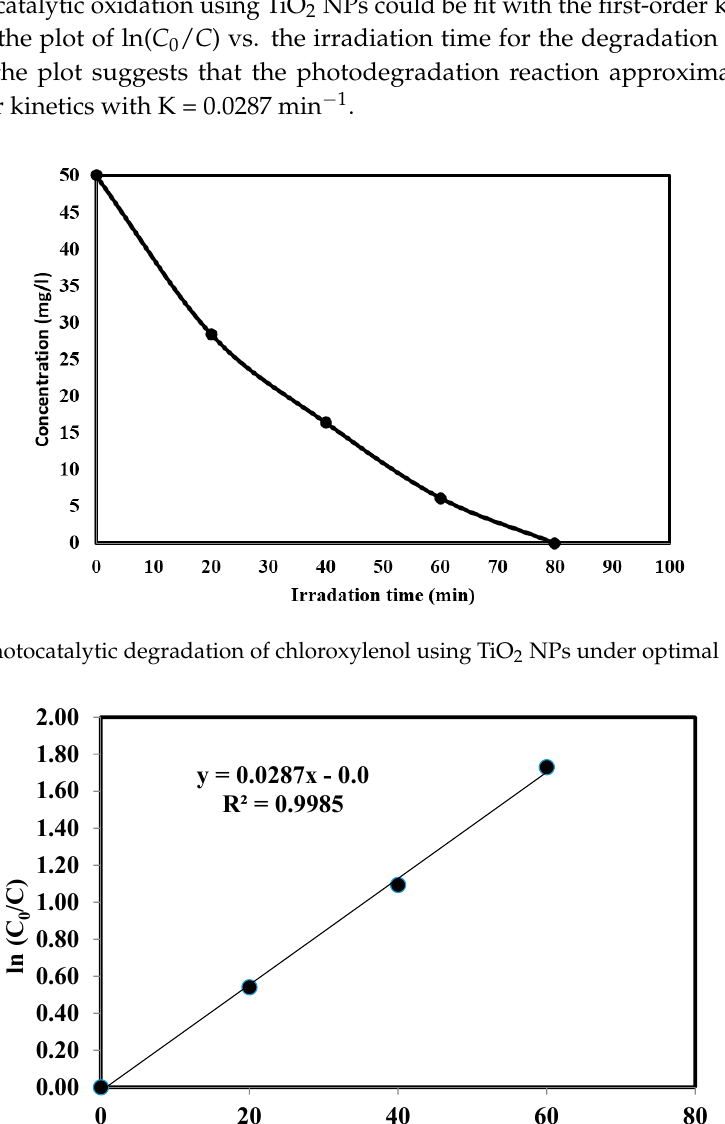
Figure 10. Plot of the pseudo-first order rate constant of photocatalytic degradation of chloroxylenol using TiO 2 NPs under optimal conditions.